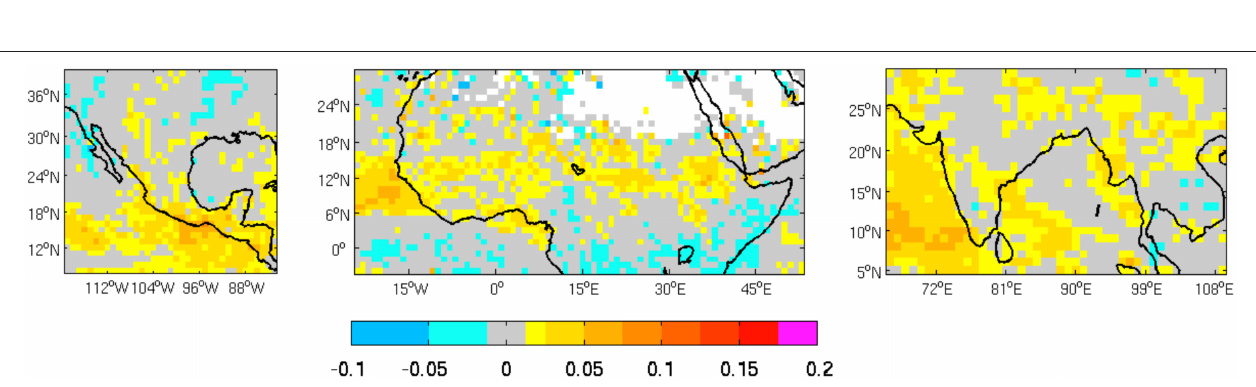
FIGURE 10 | Ranked Probability Skill Scores (RPSS) for terciles precipitation week 3–4 forecasts from the MME of ECMWF, NCEP, and CMA forecasts for all starts within the May-Aug season.